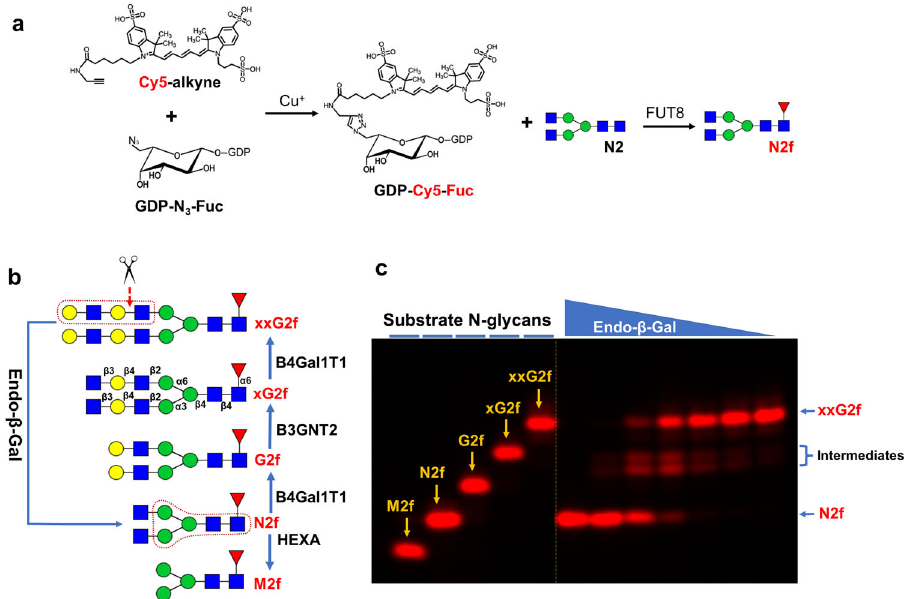
Fig. 1 Preparation of initial fi ve substrate N-glycans. a Scheme for preparing GDP-Cy5-Fuc and the Cy5-Fuc labeled glycan N2f. The Cy5-labeled Fuc was enzymatically incorporated to the chitobiose core of the glycan N2 by FUT8 to obtain the Cy5-Fuc labeled N2f. b Scheme for the synthesis of xxG2f and M2f and Endo- β -Gal digestion. All glycans were enzymatically synthesized starting from N2f. The lactosamine repeats (LN2) in xxG2f and the pentasaccharide core of N-glycans in N2f are boxed. For clarity, the glyco-bond linkages are only shown in xG2f. c Digestion of xxG2f by Endo- β -Gal. The digestions were separated on 17% SDS-gel along with all other glycans in b . Digestion of xxG2f was performed by a 2-fold serial dilution of Endo- β -Gal starting from 175 ng. The mobility of the end product of Endo- β -Gal digestion matched that of N2f, thereby validating the synthesis scheme. Dashed line indicates that the image was spliced for better comparison between the substrate and product of the enzymatic